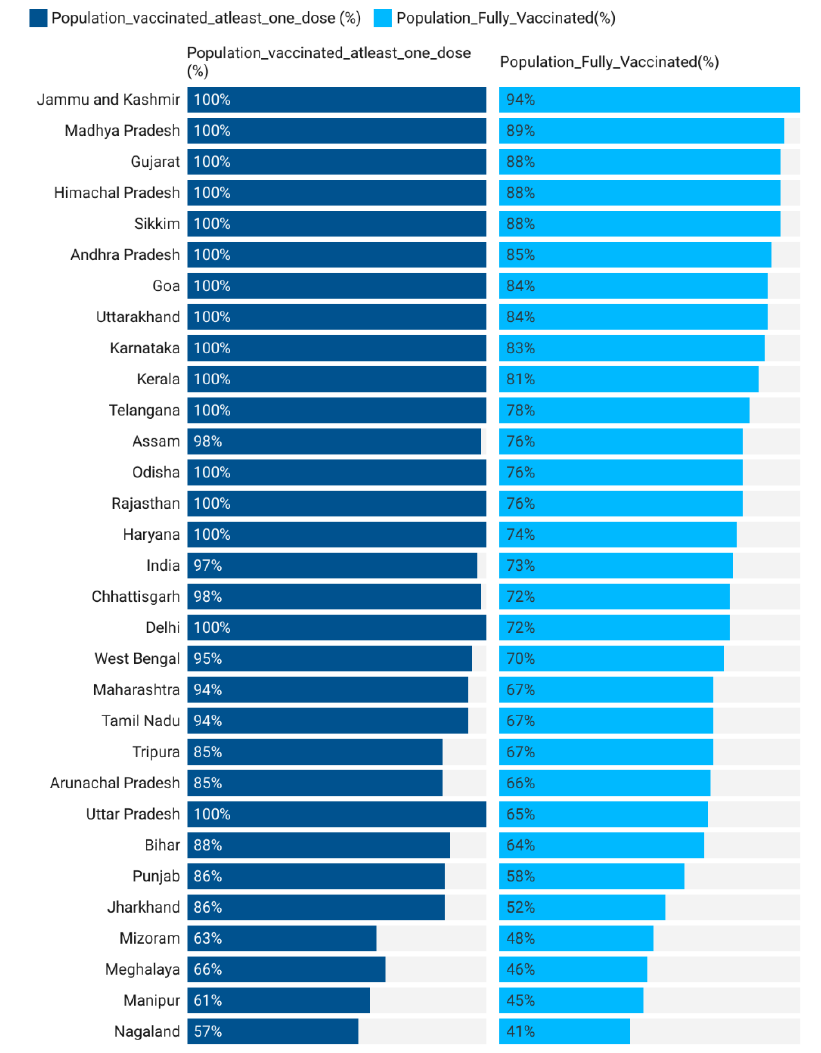
Figure 1. Progress of COVID-19 vaccination in India.